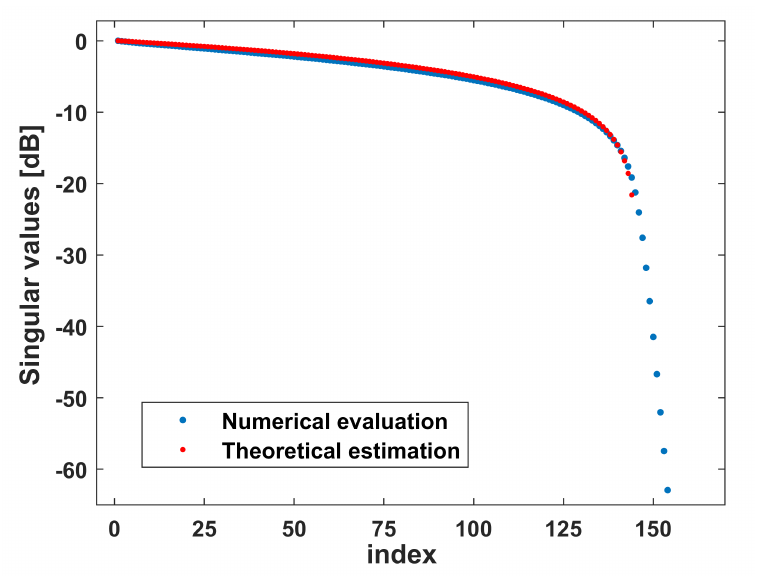
Figure 4. Singular values of A 1 numerically computed, and their analytical estimation for the configuration a = 20 λ , z 1 = 5 λ , X 1 = 20.75 λ ( η ( X 1 , z 1 ) = 0.9 ) .